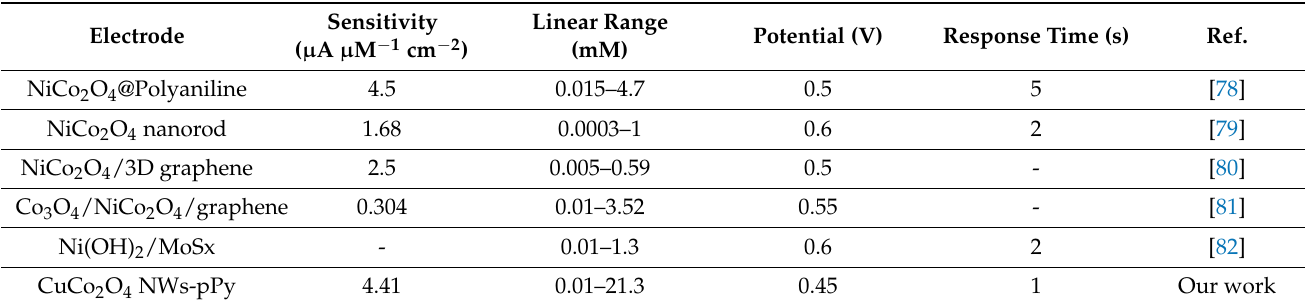
Table 1. Comparison between the CuCo 2 O 4 NWs-pPy@CCE-based sensor with other reported nonenzymatic electrochemi- cal sensors.